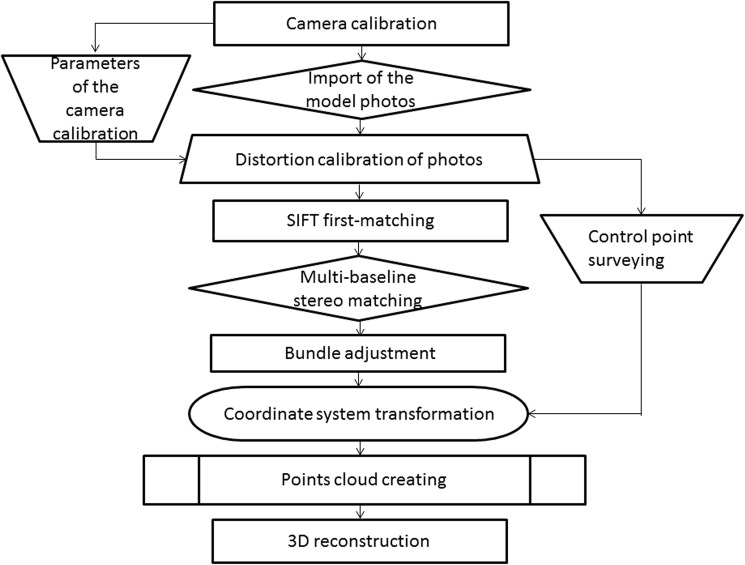
Schematic illustration of the 3D model reconstruction procedures.